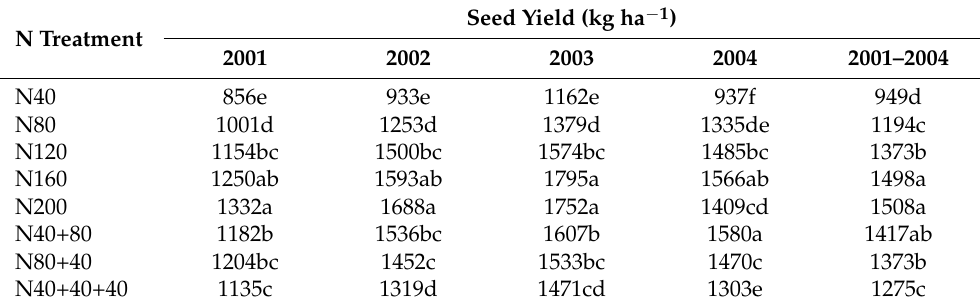
Table 3. Seed yield in kg ha − 1 within years and nitrogen (N) treatments and as an average of years. Different letters within each year show significant differences at a 5 percent